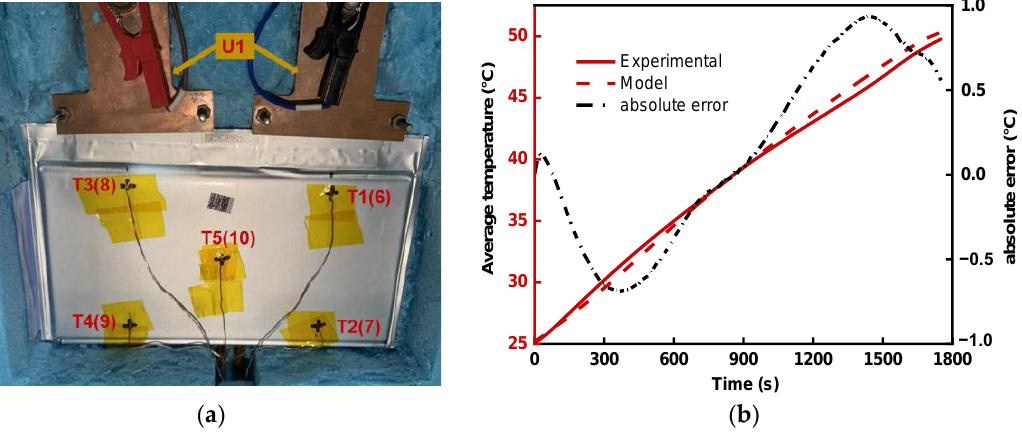
Figure 3. Experimental validation of the model. ( a ) Temperature monitoring points of the lithium-ion battery in the experiment; ( b ) comparison of experimental data with model data.